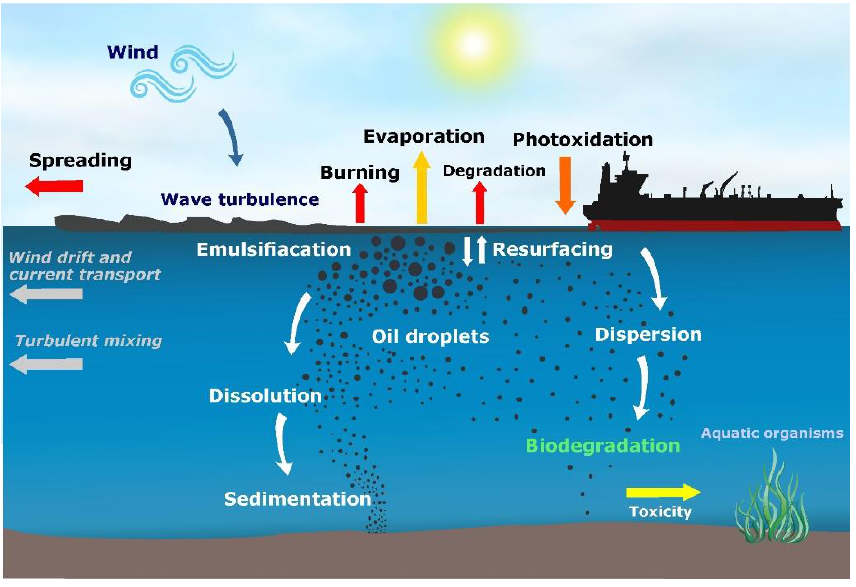
Figure 1. Main transport and weathering processes (OWPs) affecting the oil spill.